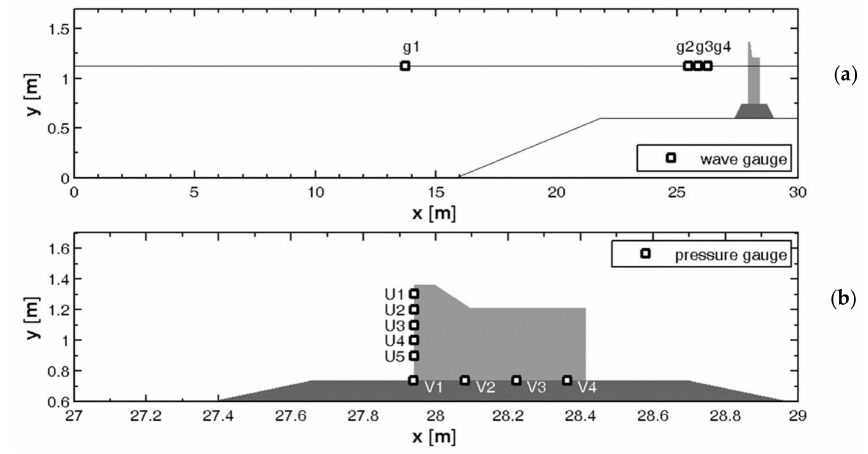
Figure 1. Experimental setup for regular wave [34]. ( a ) is the side view; ( b ) is the detailed view of the caisson